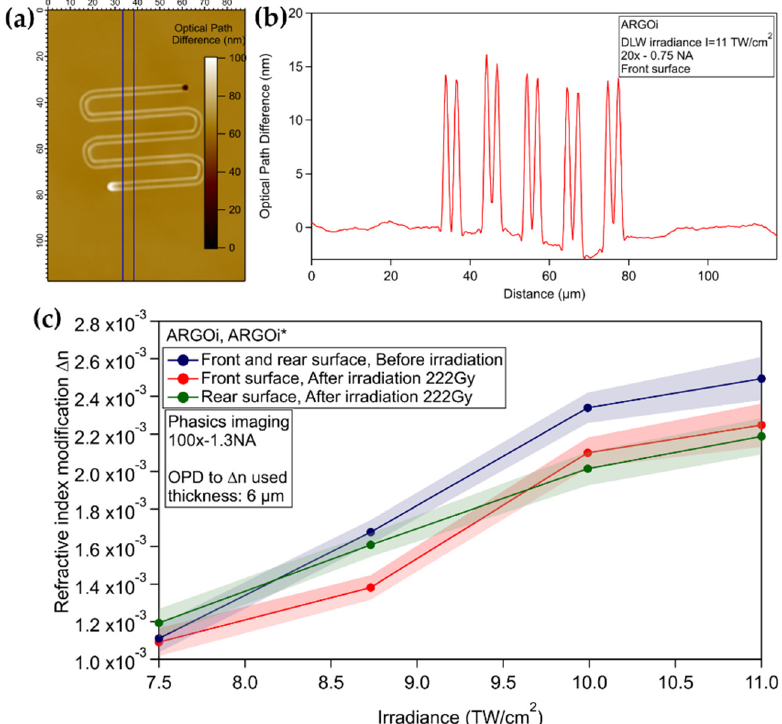
Figure 10. ( a ) Phase image under white light illumination of the laser inscribed structure (11 TW/cm 2 ) before irradiation. ( b ) Optical path difference determined from the phase image. ( c ) The refractive index modification ∆𝑛 as a function of laser irradiance before/after 222 Gy-dose for the two planes in ARGOi, ARGOi* glass sample.